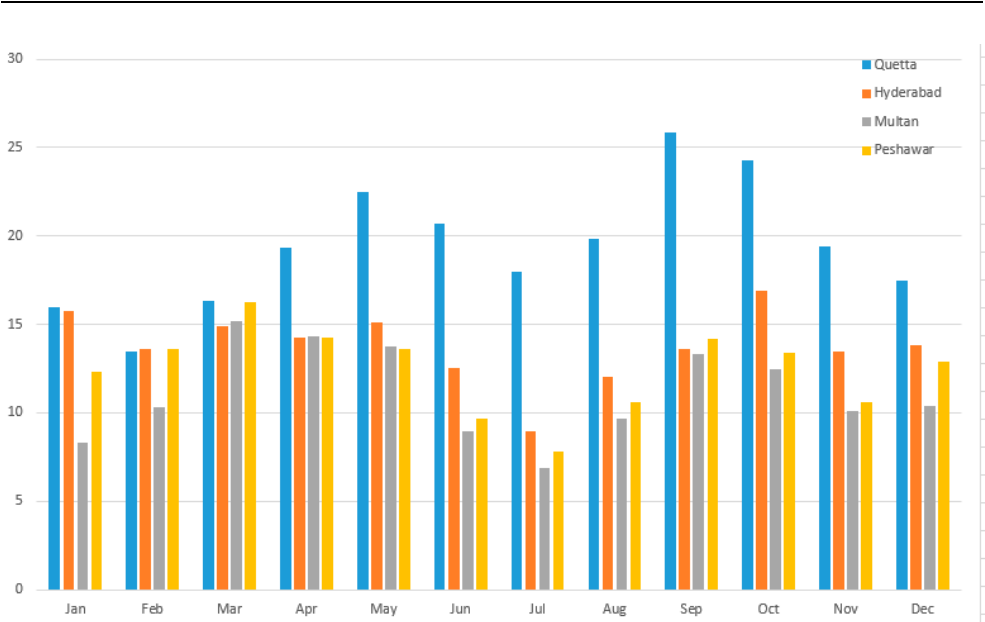
Figure 15. Heliostat field of the 50 MWe SPT plant.